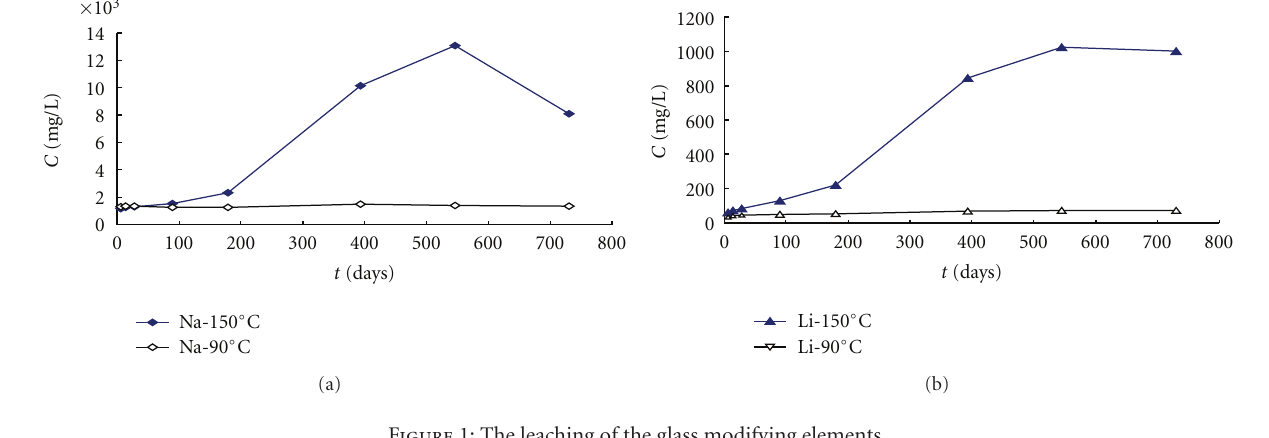
Figure 1: The leaching of the glass modifying elements.